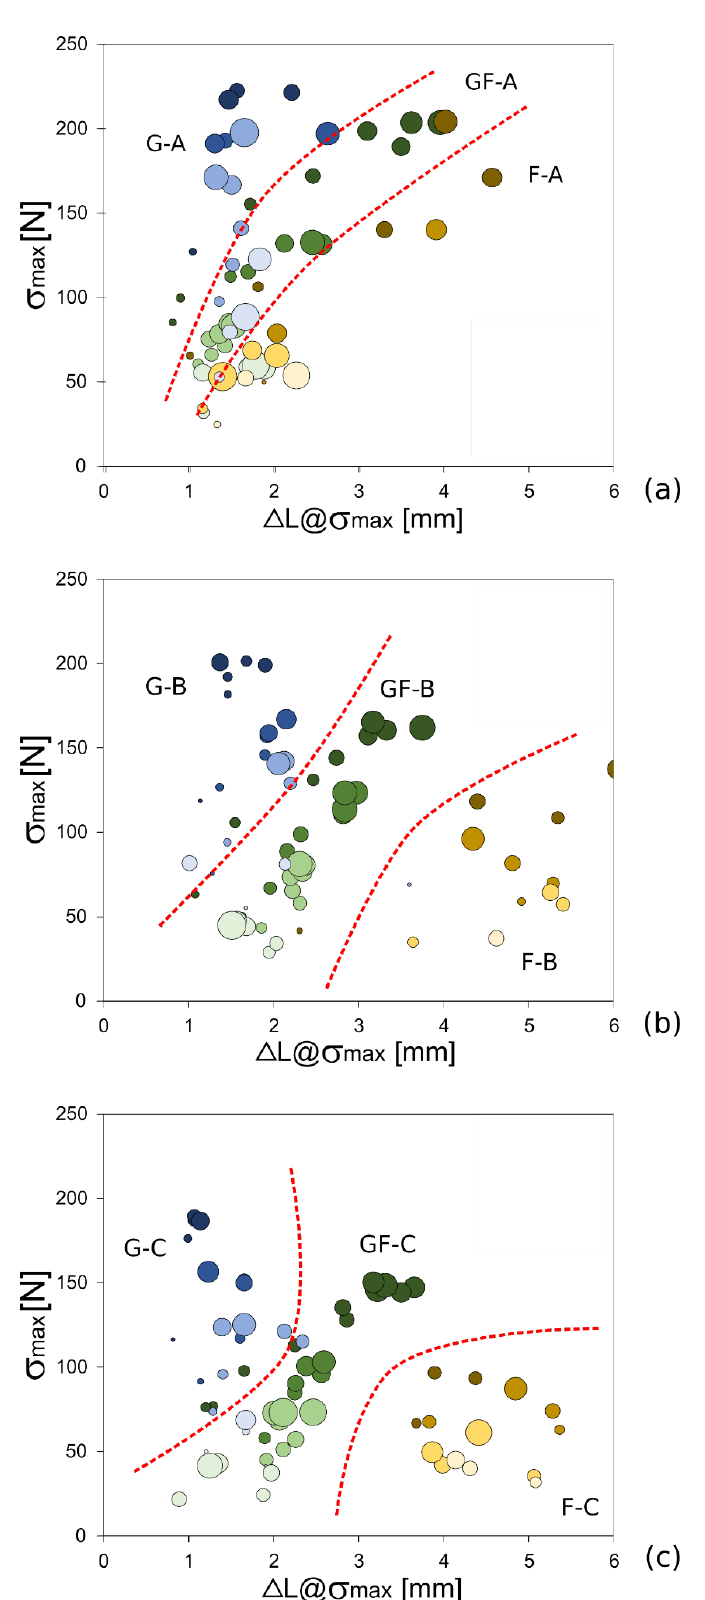
Figure 6. Maximum bearing stress ( σ max ) vs displacement at maximum stress (ΔL@σ max ) curves for all composite batches at varying the salt-fog exposition time: ( a ) batches A (unaged samples), ( b ) batches B (aging time: 30 days) and ( c ) batches C (aging time: 60 days).